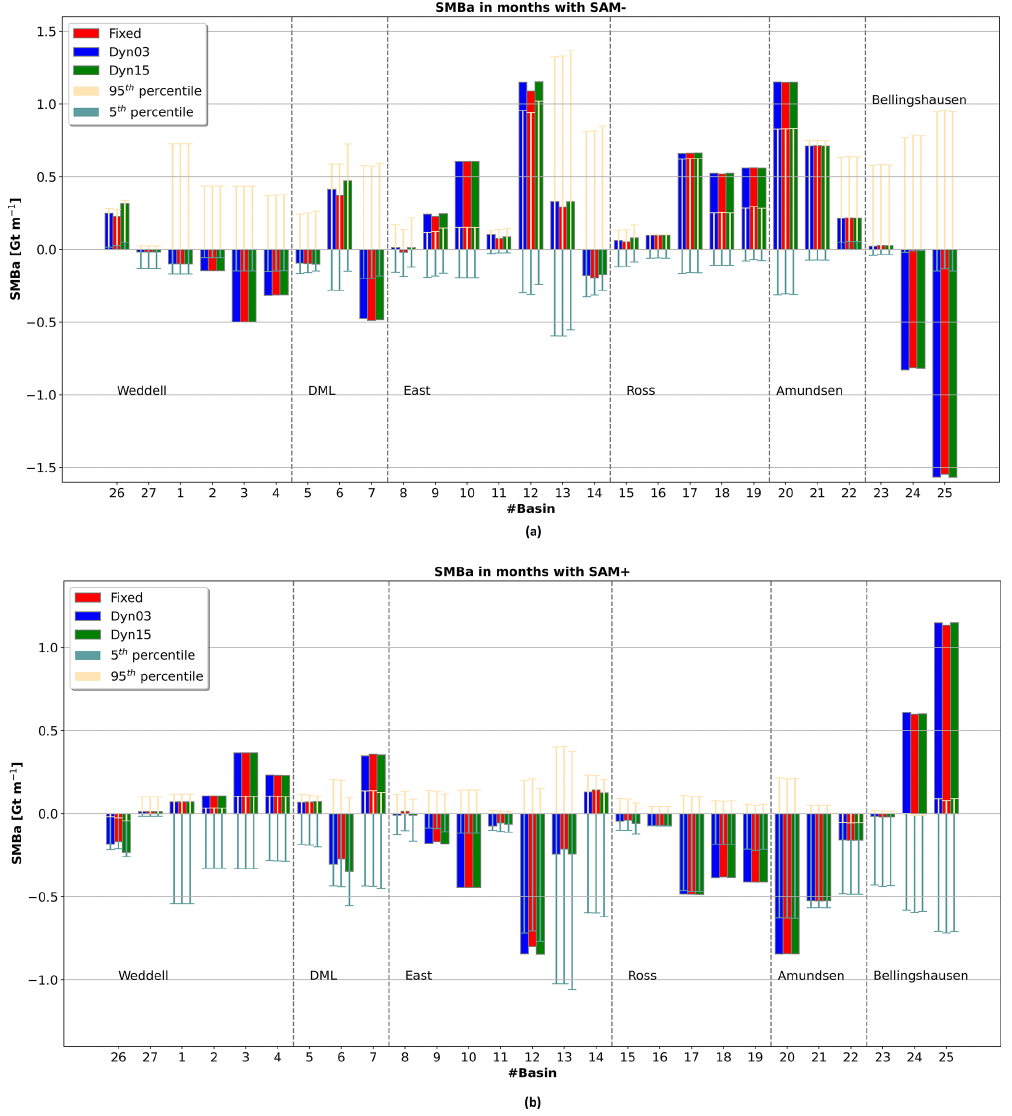
Figure 9. SMBa (monthly values minus mean values) in months for SAM − (a) and SAM + (b) , for each basin. The vertical dashed lines split the basins into areas. Starting from the left, we show basins towards the Weddell Sea, Dronning Maud Land, eastern coast, Ross Sea, western coast/Amundsen Sea, and Bellingshausen Sea. The thin bars are the 5th and 95th percentiles, for the bootstrapping analysis with 1200 runs. Locations of the basins can be seen in Fig. 4. In basins where the SMBa values fall outside the percentiles, there is a robust relationship between the SMB and